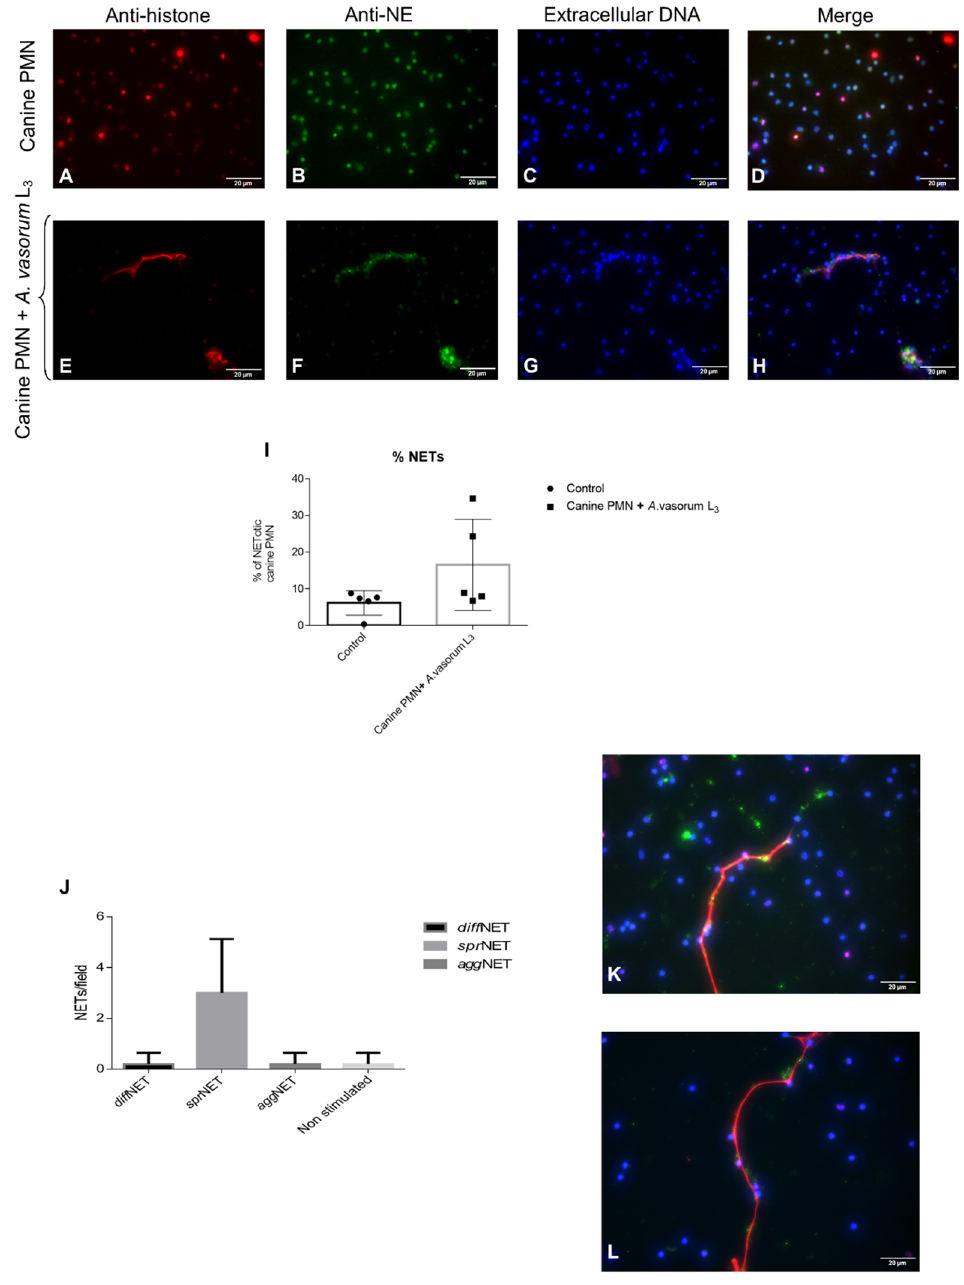
Figure 2. Immunofluorescence analyses of Angiostrongylus vasorum L3-induced neutrophil extracellular trap (NET) formation. Co-localization analyses on extracellular DNA, histones, and neutrophil elastase were performed. Presence of extracellular DNA ( C , G ; blue), anti-histone ( A , E ; red) and anti-NE ( B , F ; green) was confirmed. ( D , H ) depicts the merging of the three channels. ( I ) reveals the percentage of A. vasorum L3-triggered NETosis. ( J – L ) demonstrate the presence of spread NETs ( spr NETs).